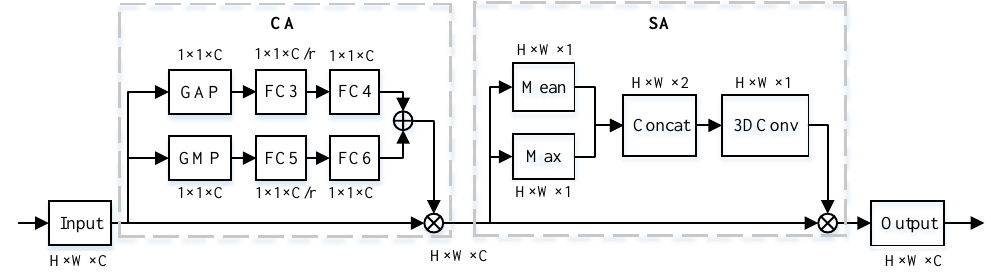
Figure 8. The detailed structure of the CA and SA in the CBAM. The H × W × C represents the data with the H height, W width, and C channels. r is the compression ratio. ⊕ denotes elementwise summation. Mean and Max represent the average pooling and maximum pooling. Concat means feature